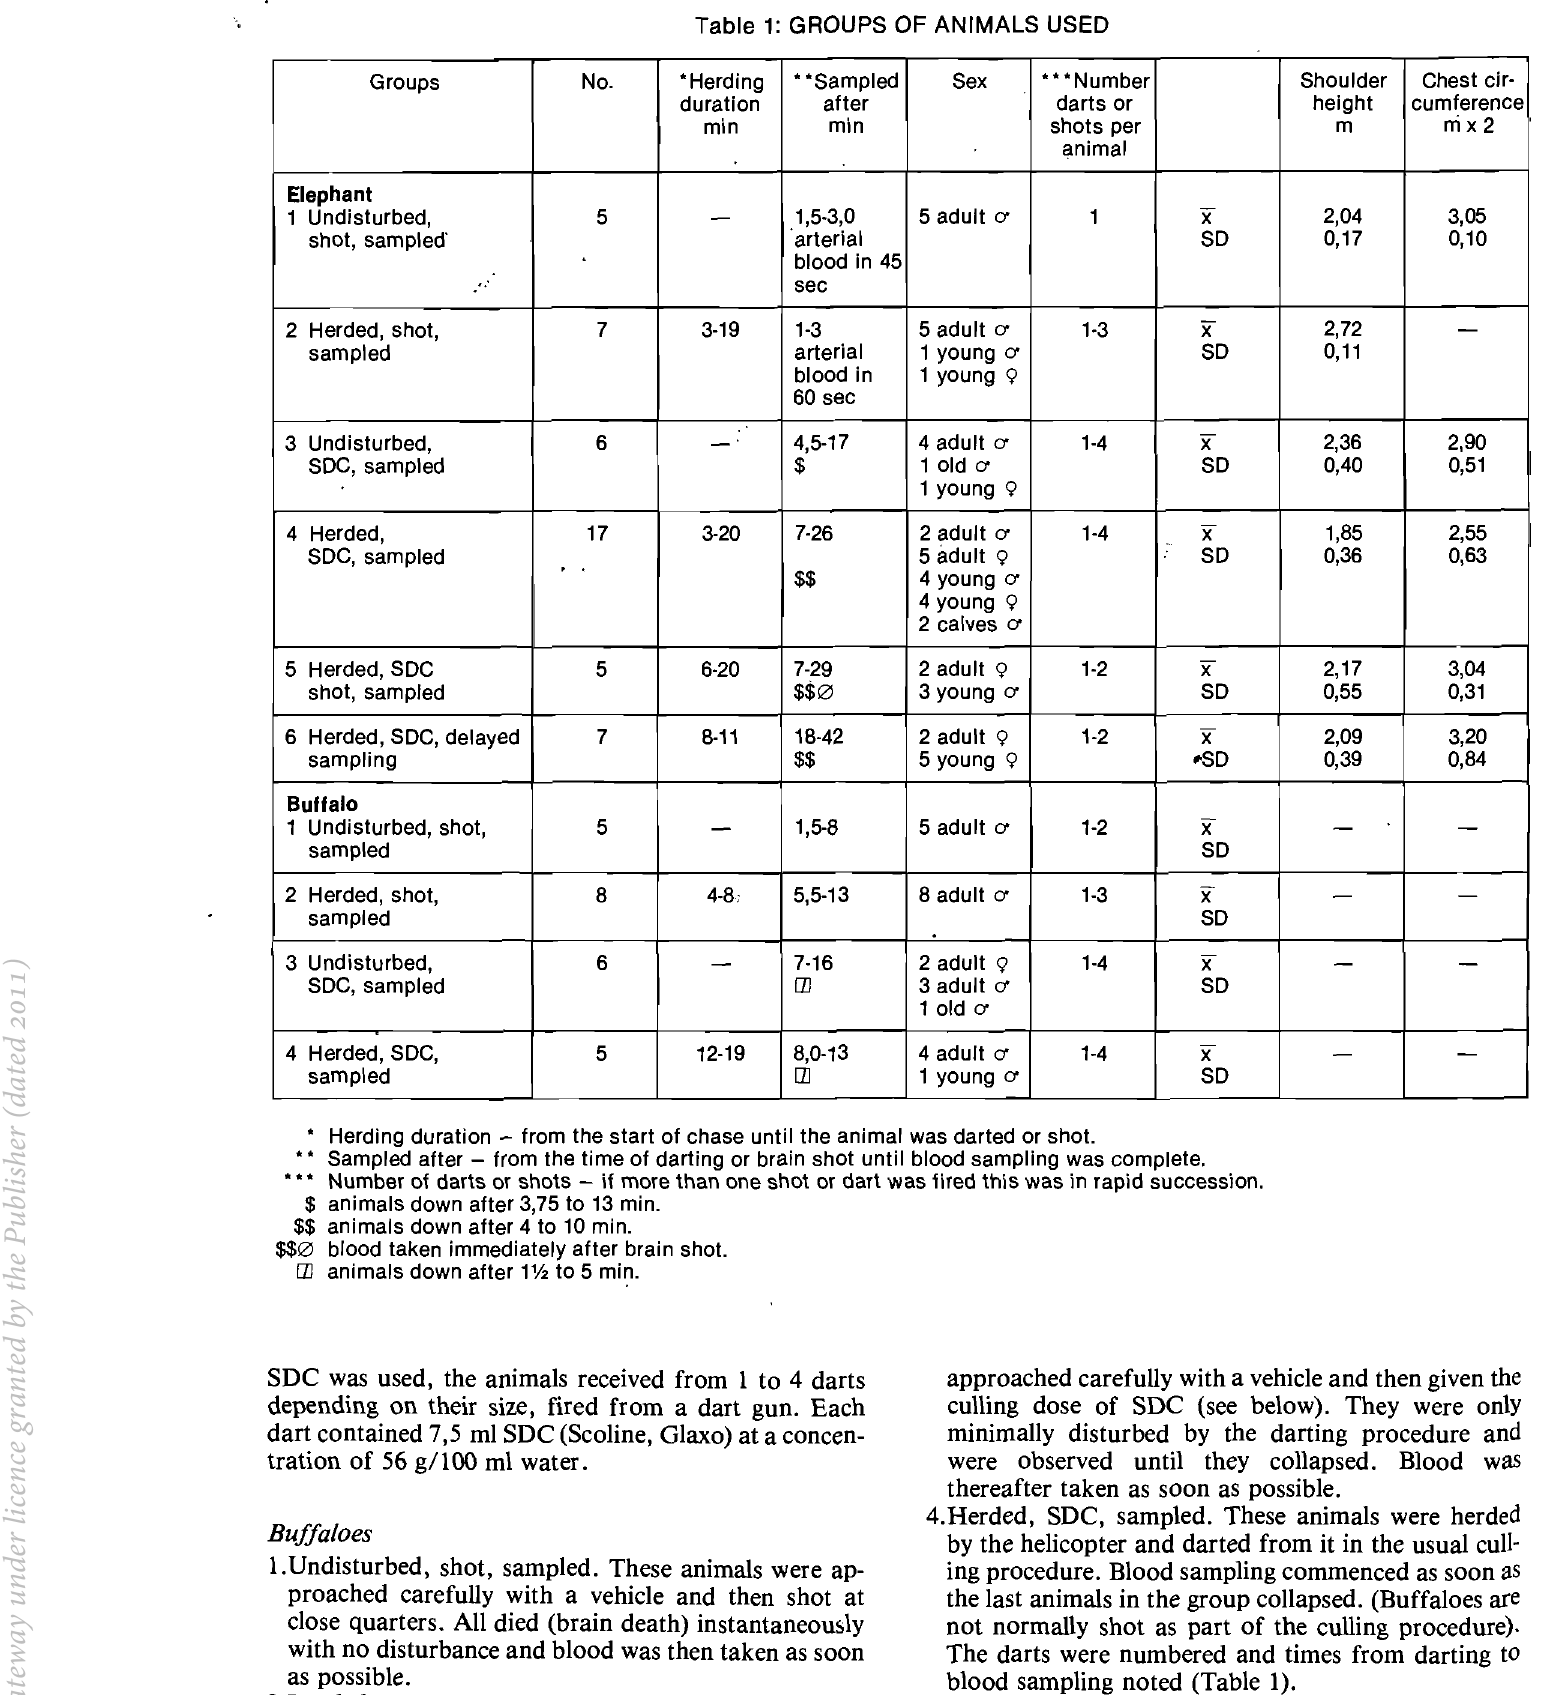
Table 1: GROUPS OF ANIMALS